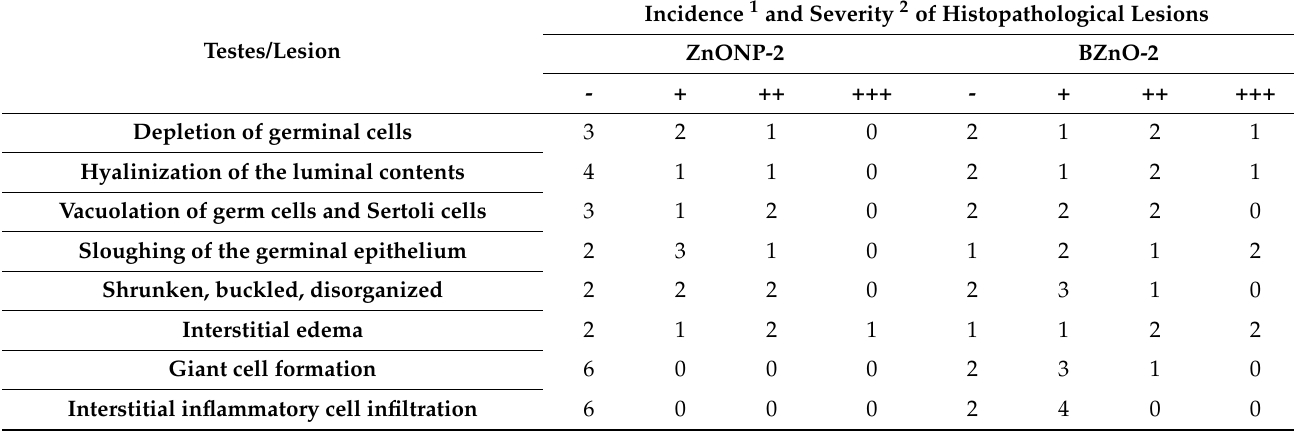
Table 2. Incidence and severity of the histopathological lesions in the testes of the ZnONP-2- and BZnO-2-treated rat groups.